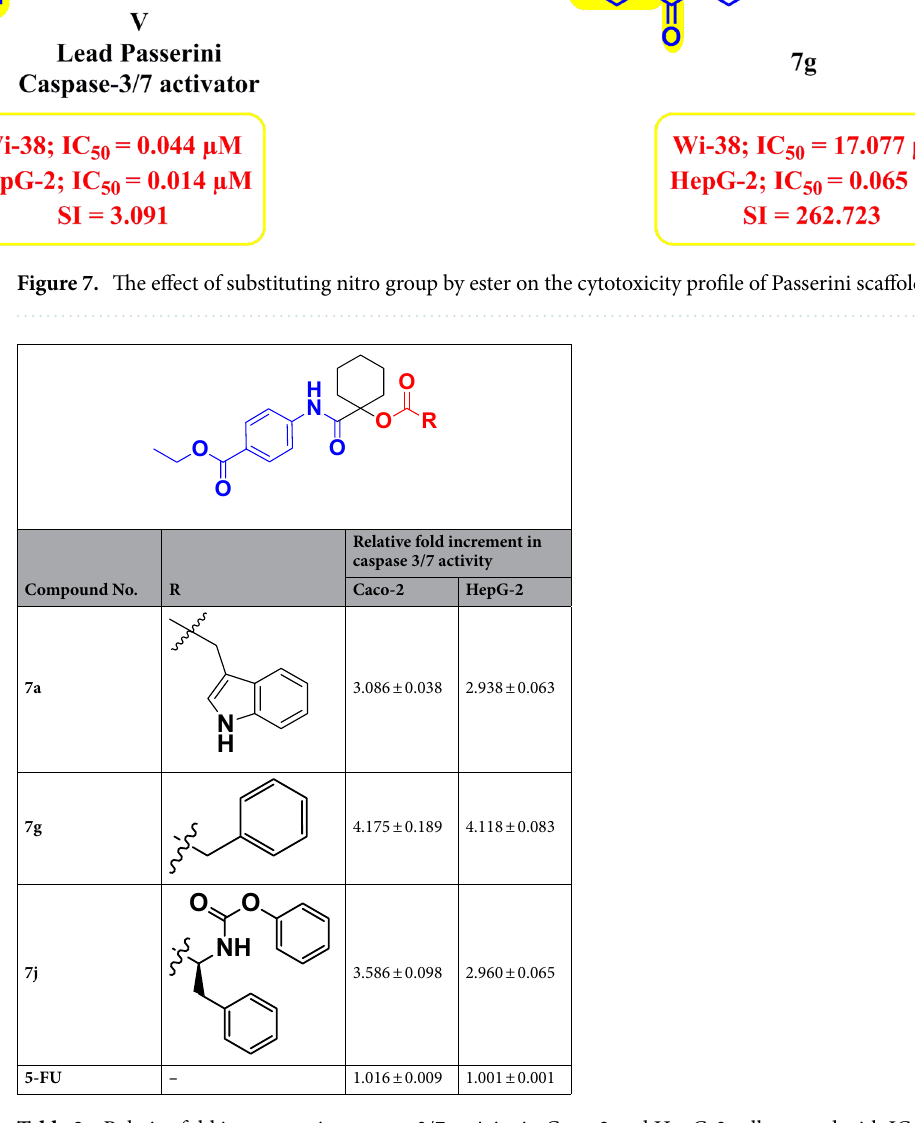
Table 2. Relative fold increment in caspase-3/7 activity in Caco-2 and HepG-2 cells treated with IC 50 doses of selected Passerini adducts. *All the values are expressed as mean ± SEM. 5-FU stands for 5-fluorouracil.